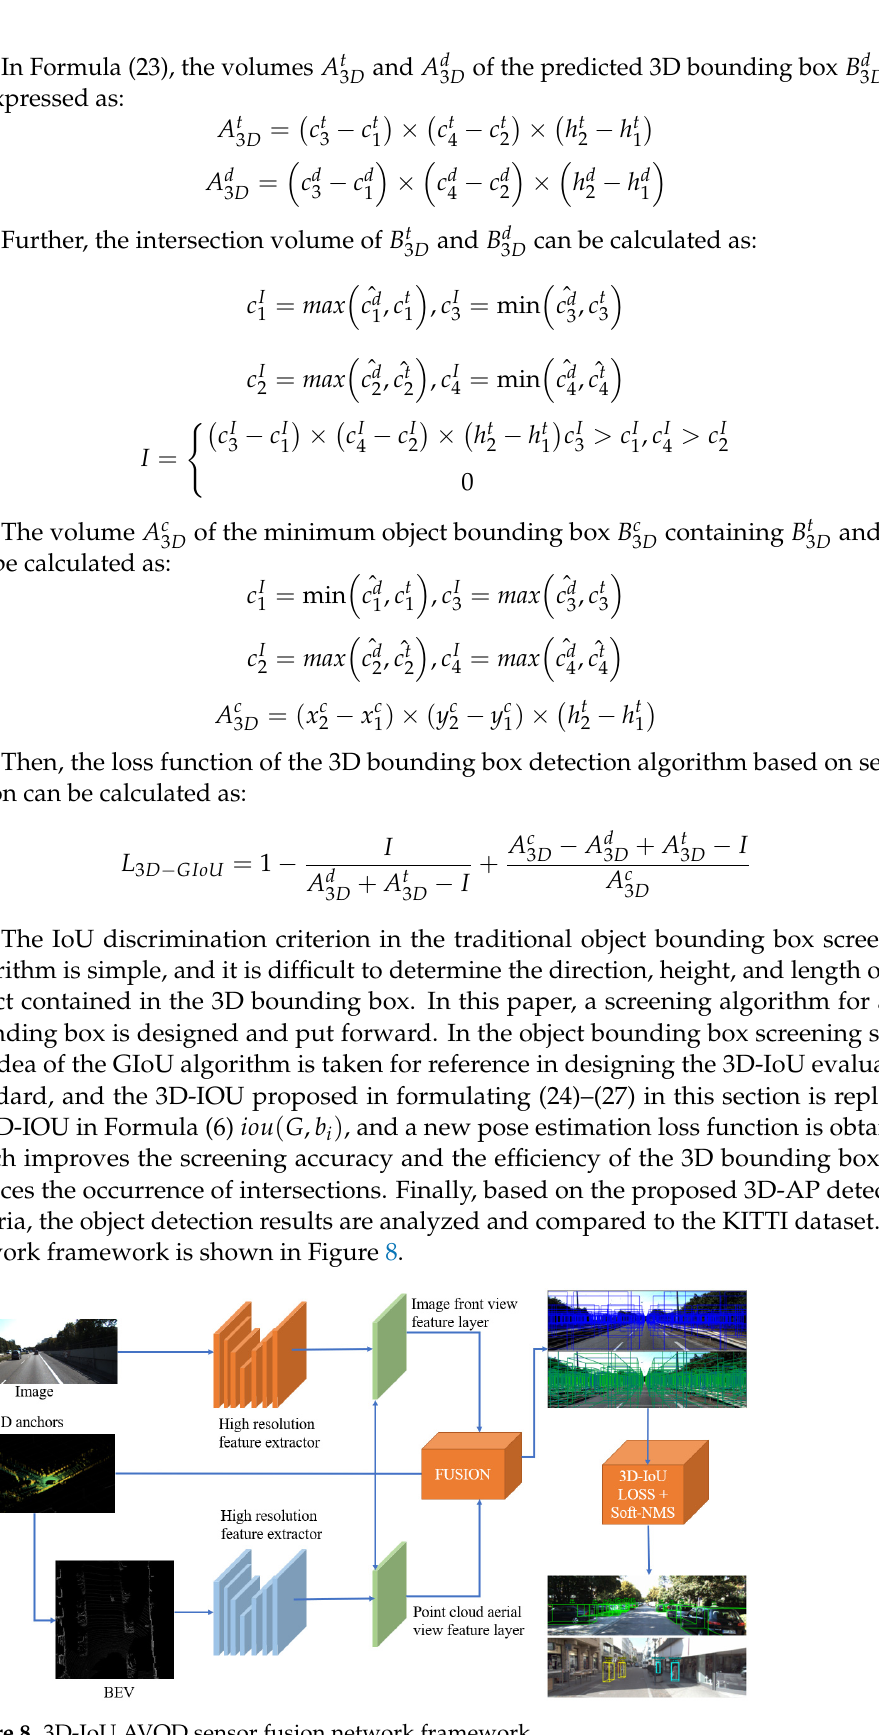
Figure 8. 3D-IoU AVOD sensor fusion network framework.